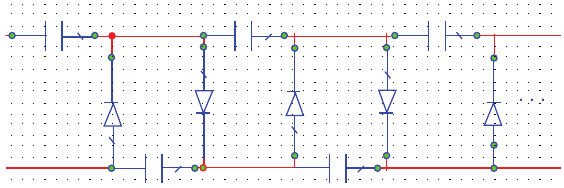
Figure 6: Villard voltage multiplier.